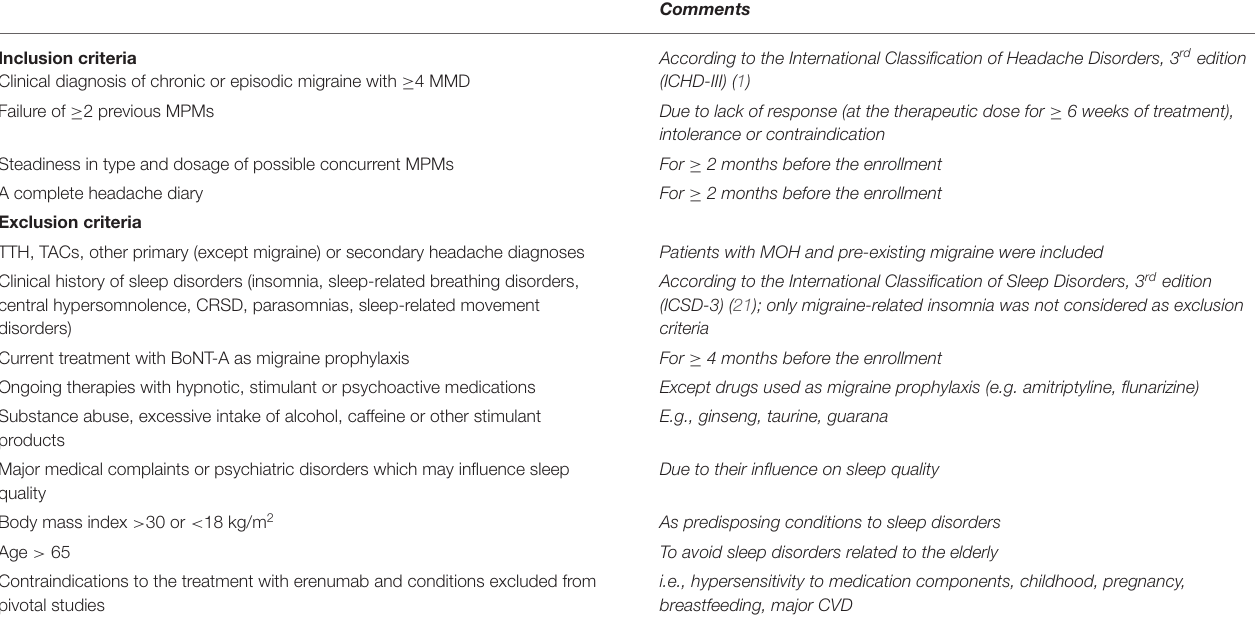
TABLE 1 | Study eligibility